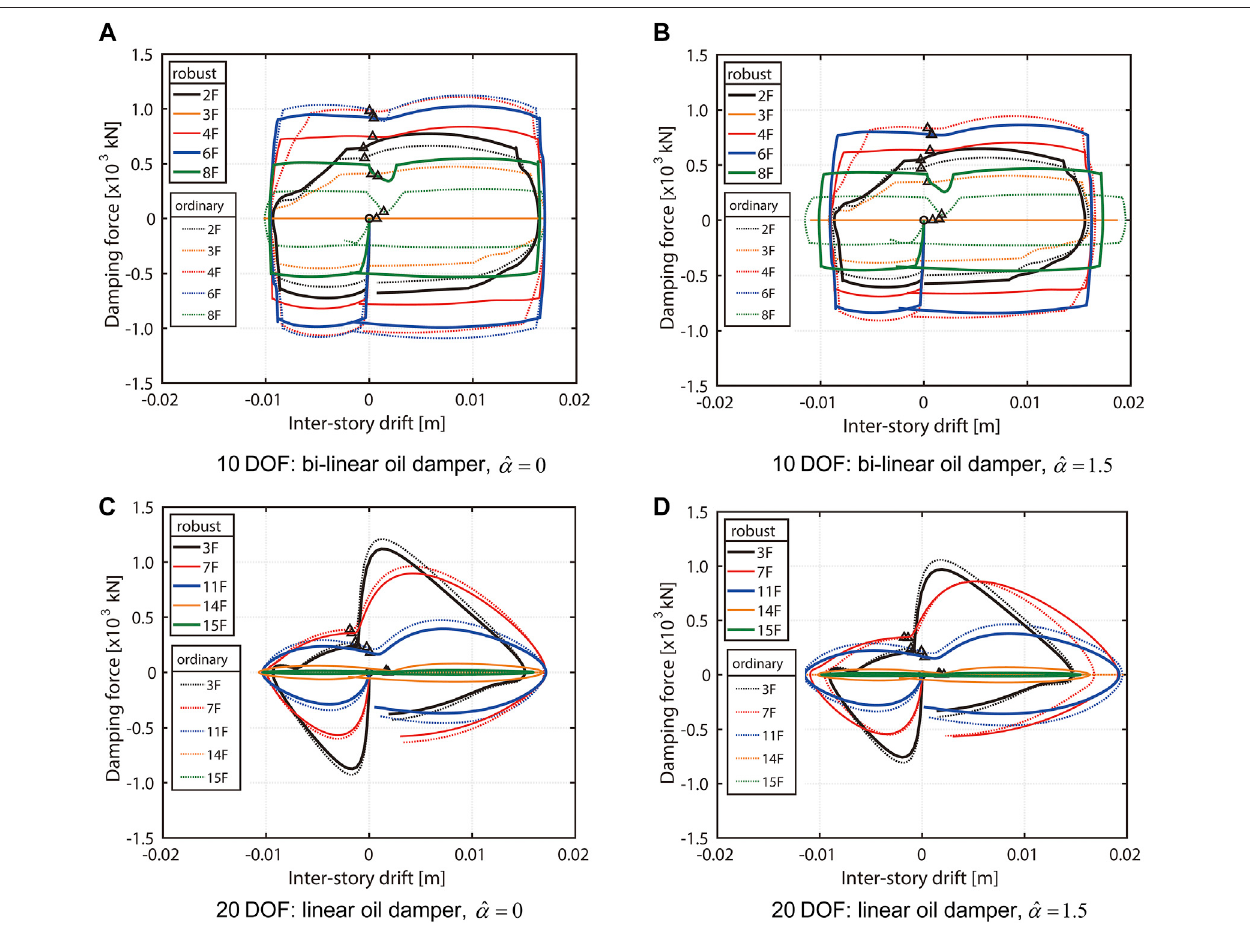
FIGURE 14 | Damping force-interstory drift relations of models designed for linear oil damper and bi-linear oil damper using proposed robust optimal design method (case without uncertainty (cid:10) α (cid:2) 0 and case with uncertainty (cid:10) α (cid:2) 1 . 5).